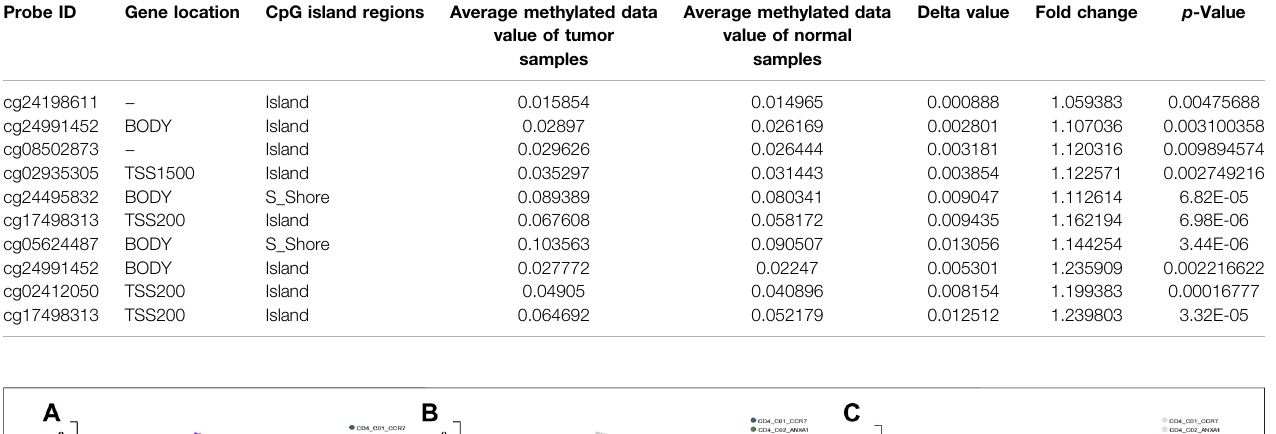
TABLE 1 | Differences in methylation levels of Mapk14 probes between CRC and normal